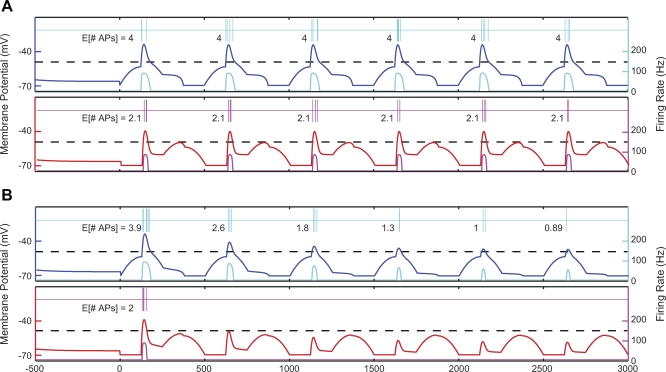
Response of Model to a Moving Sine Grating Following 500 msec Initialization with 50% Grey(A) The one-state model with the fast process alone, s = 1.(B) The two-state model with both the fast and slow processes, s = 0.99. Blue and red (middle trace of each subpanel) shows membrane potential, V
∞(t). Cyan and magenta shows firing rate, F(t) (beneath V
∞(t), and timing of action potentials determined from F(t) by a Poisson process (above). Blue and cyan (top subpanel in both A and B): preferred direction (σ = 1); red and magenta (bottom subpanel): non-preferred direction (σ = −1). Small numbers are the expected action potentials in each cycle. Black dotted line indicates threshold for action potentials. In the one-state model, the direction index (defined in Model) is constant across all cycles at 0.48. In the two-state model, the direction index increases from 0.49 to 1—the two-state model becomes more direction selective with time. Other parameters of model are Rb = 5 Hz, Rc = 172 Hz × log(67 × 0.2), xn = −45°, xd = 45°, tD = 150 msec, tS = 3,000 msec, d = 0.4, gd = 15, gn = 0.7,V
0 = 0.7, V
0 = 70 mV, VE = 0 mV, Vt = −64 mV, Vr = −65 mV, tm = 30 msec, tR = 10 msec. Other parameters of the stimulus are t
0 = −500 msec, ts = 0 msec, tf = 3,000 msec, f = 2 Hz, p
0 = ∞, p
1 = −∞.